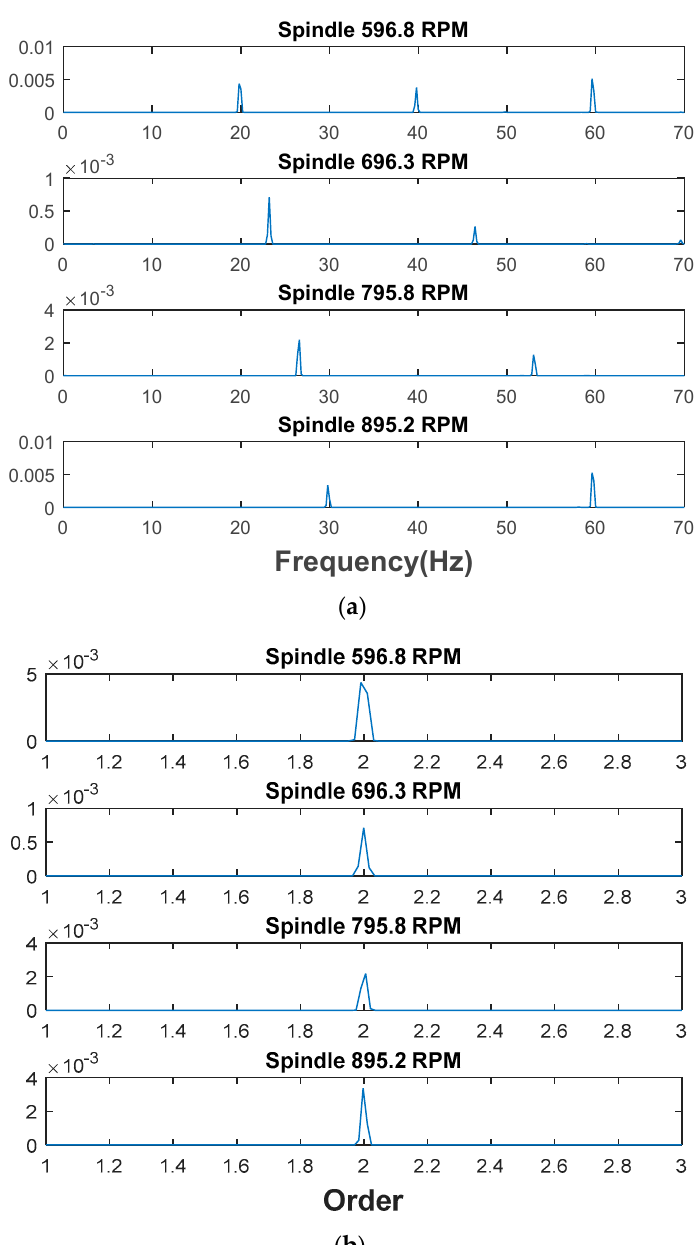
Figure 4. Illustration of spindle rotating speed-related frequency-domain features: ( a ) Spectrum of vibration signal under different spindle rotating speeds; ( b ) Order spectrum of vibration signal under different spindle rotating speeds.